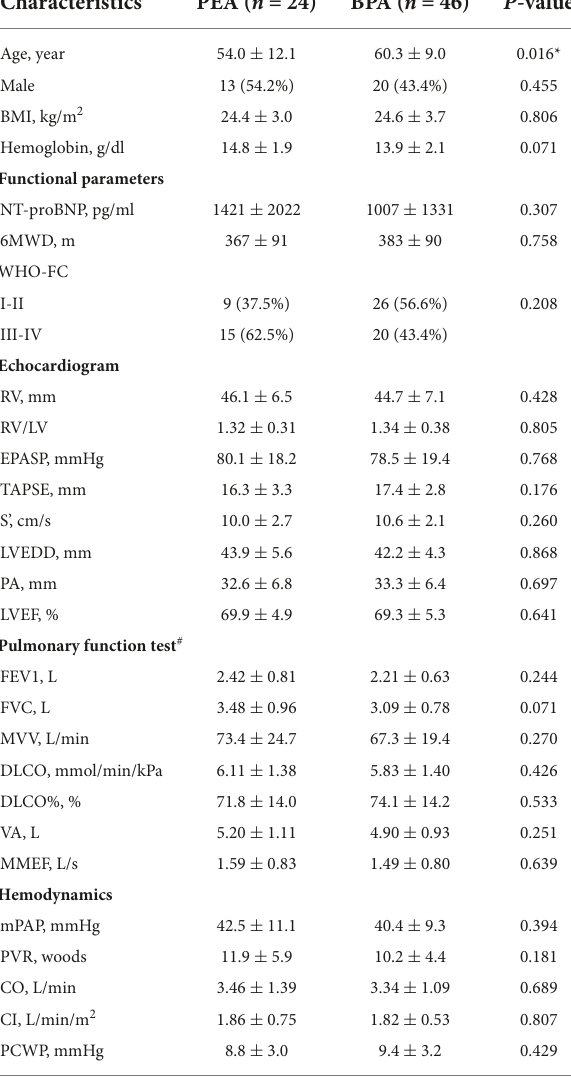
TABLE 1 Baseline characteristics of CTEPH patients before PEA and BPA.